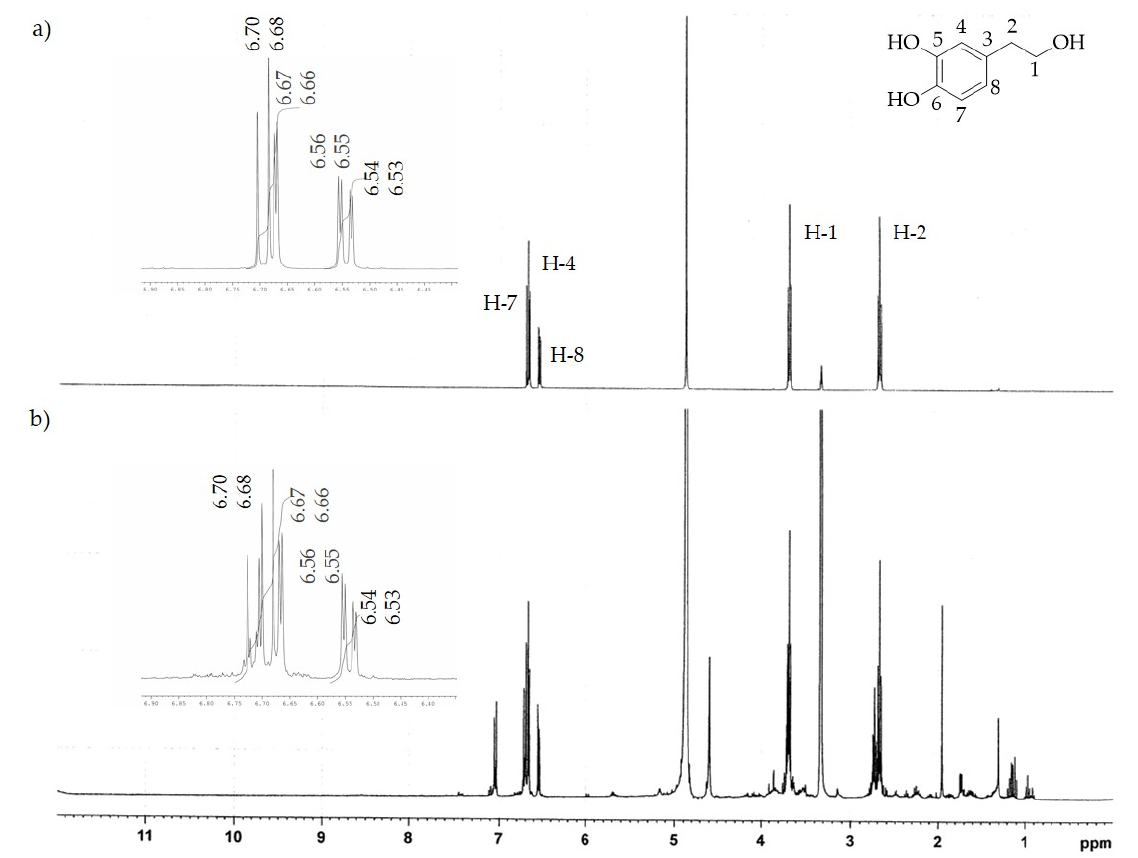
Figure 3. 1 H-NMR spectrum of ( a ) HTyr; ( b ) HTyrE.